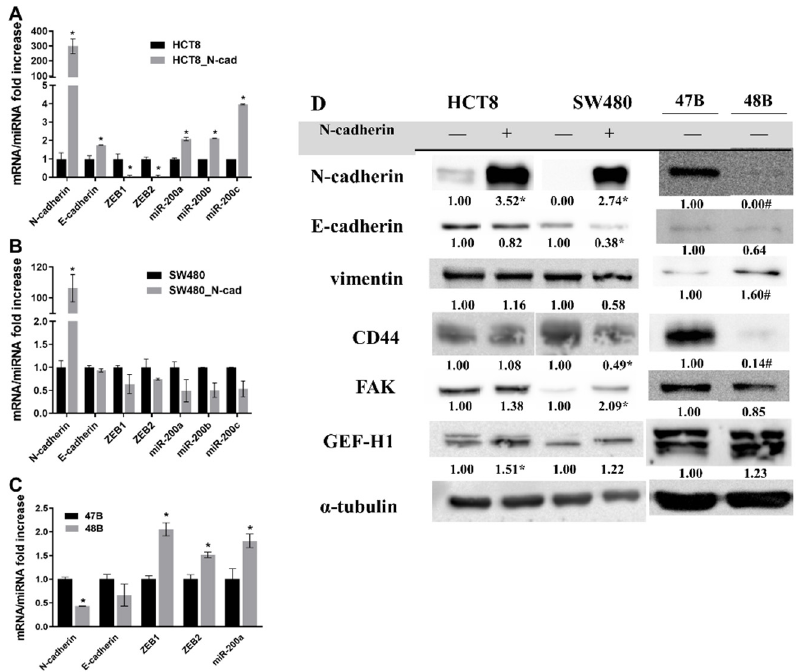
Figure 1. Comparison of miRNA, mRNA and protein levels of selected epithelial to mesenchymal transition (EMT) and cell migration potential markers as measured by RT-PCR and Western blot analysis (Materials and methods). ( A ) mRNA and miRNA of EMT markers in HCT8 and HCT8_N- cad cells; ( B ) mRNA and miRNA of EMT markers in SW480 and SW480_N-cad cells; ( C ) mRNA and miRNA of EMT markers in 47B and 48 primocultures; ( D ) protein expression of selected EMT and cell migration potential markers in HCT8, SW480 and its _N-cad variants, 47B and 48B primocultures. Numbers indicate densitometric analysis results. B2M was used as a reference gene in